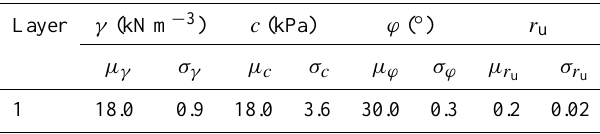
Table 2. Mean values and standard deviations for soil property pa- rameters.